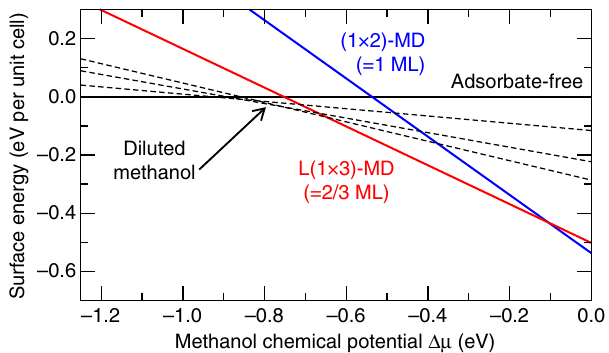
Figure 3 | Surface phase diagram. Thermodynamic stability of the adsorbate-free and various methanol-covered rutile TiO 2 (110) surfaces as function of the methanol chemical potential of a surrounding gas phase.